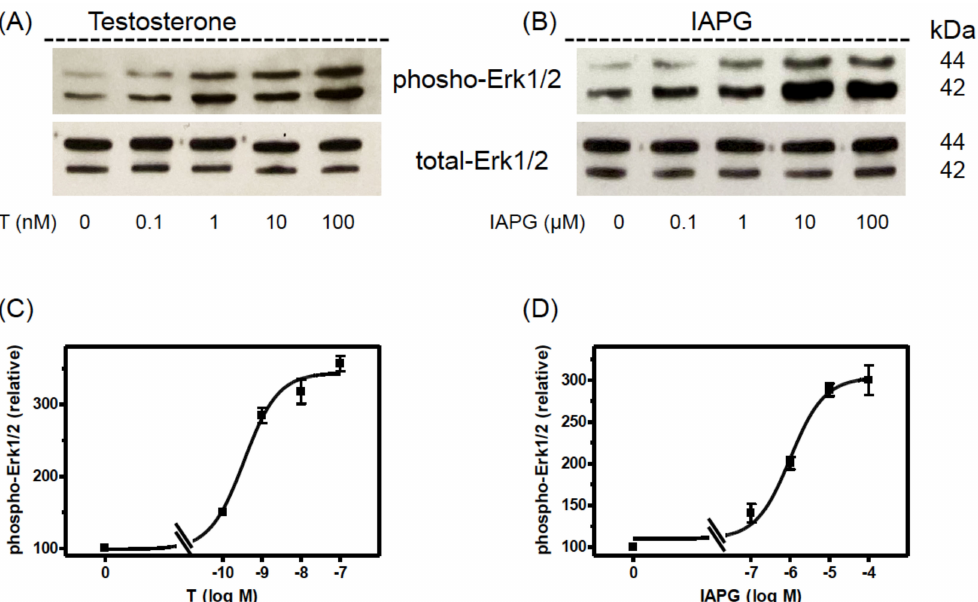
Figure 5. Western blot analysis of phospho-Erk1/2. PASC1 cells were stimulated for 24 h with various concentrations of testosterone or IAPG. ( A ) Phospho-Erk1/2 detection after stimulation with testosterone and ( B ) after stimulation with IAPG. In ( A , B ) the total amount of Erk1/2 was not affected. ( C ) Semi-logarithmic plot of relative p-Erk1/2 signals revealed for testosterone an EC 50 of 0.35 ± 1.29 nM and ( D ) for IAPG an EC 50 of 1.02 ± 1.36 µ M. For each diagram: n = 3; means ± SEM. Original Western blots are shown in Supplementary Figure